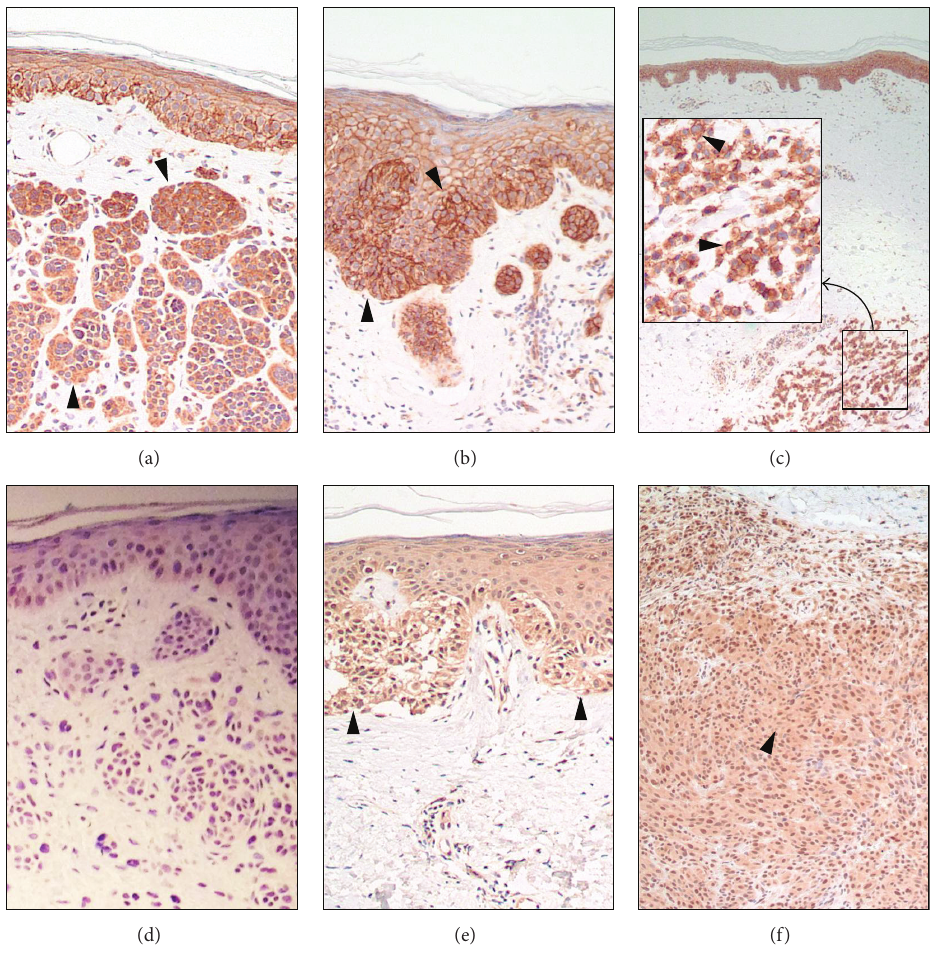
Figure 1: Representative pictures of 𝛽 -catenin ((a)–(c)) and Rad6 ((d)–(f)) staining in nevus ((a), (d)), primary melanoma ((b), (e)), and metastatic melanoma ((c), (f)). Closed arrowheads point to positively immunostained cells. The highlighted square in panel (c) is magnified. Original magnification ×